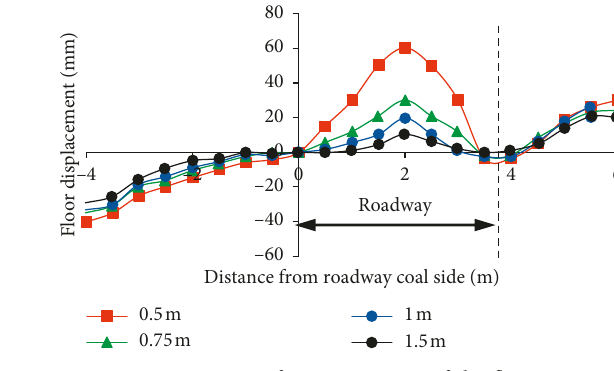
17: Deformation curve of the